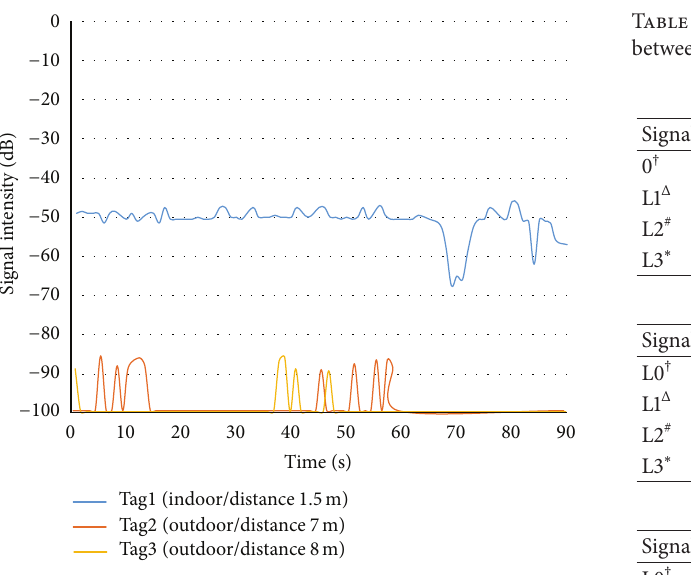
Figure 5: Signal Strength received by the reader placed inside the lab room.